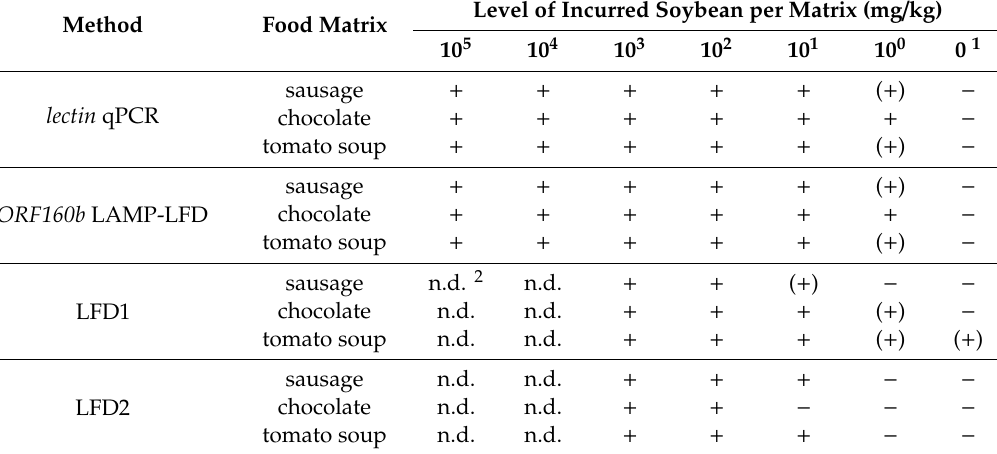
Table 3. Qualitative results from the analysis of soybean incurred in food matrix using qPCR, LAMP-LFD, and two commercial LFD tests, strictly according to the manufacturers’ instructions. ( + : all replicates positive; − : all replicates negative; ( + ): not all replicates of LAMP / qPCR tested positive, or faint test line in commercial